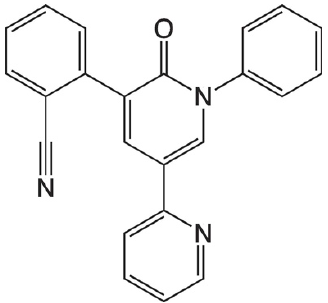
Figure 5. Molecular structure of